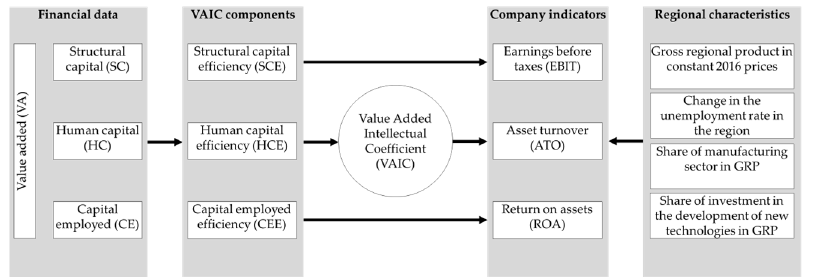
Figure 1. Model for intellectual capital management in Russian manufacturing enterprises. Source: own construction.